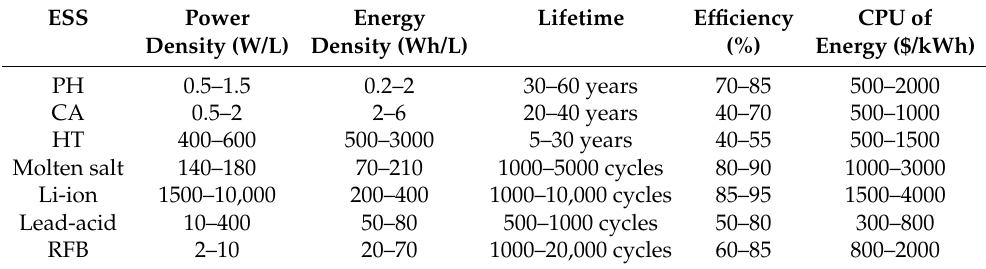
Table 1. Comparison of the main indicators of ESS. Extracted from [11–13].